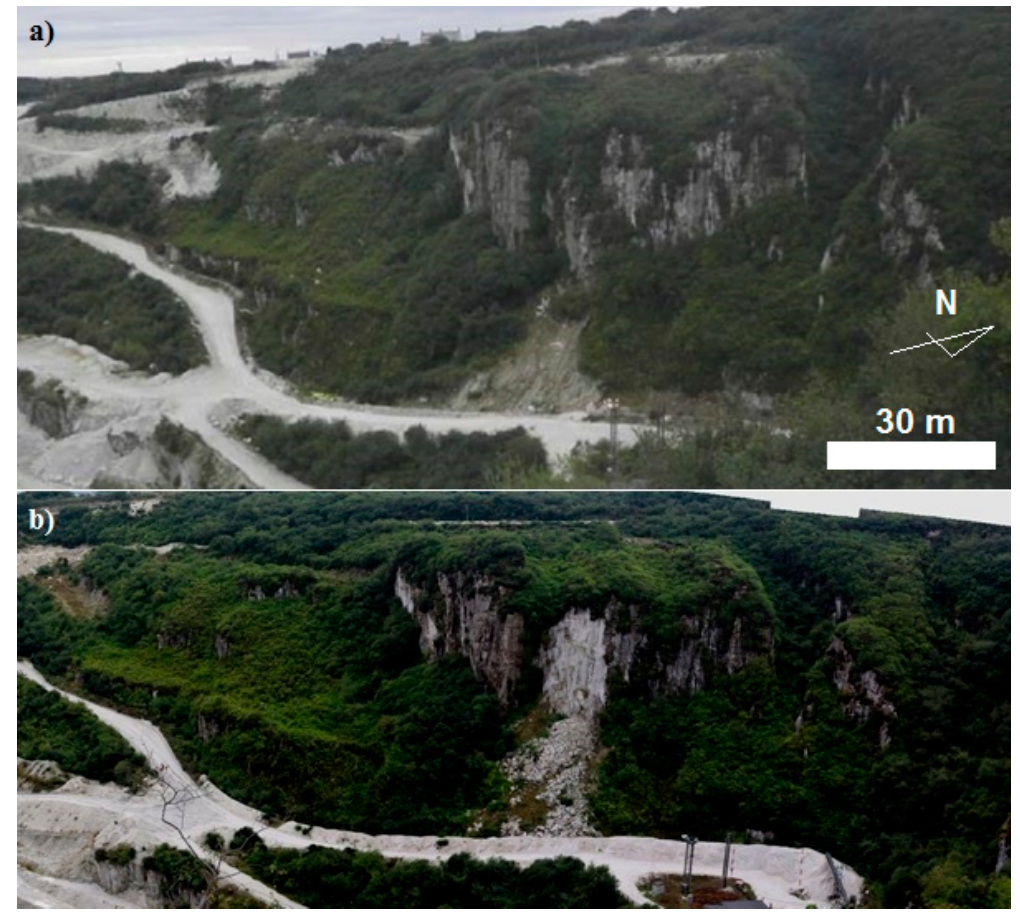
Figure 2. Photographic comparison of the rockfall ( a ) October 2013 and ( b ) August 2018. The photos were taken from the opposite side of the pit, circa 300 m away from the target and they show the change in geometry due to the major collapse occurred in early 2016. Scale bar is indicative.